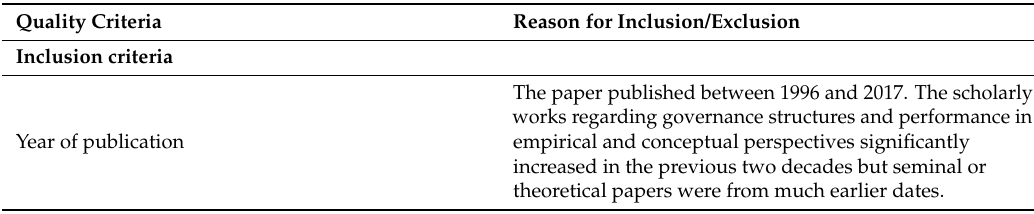
Table 1. The quality criteria for inclusion and